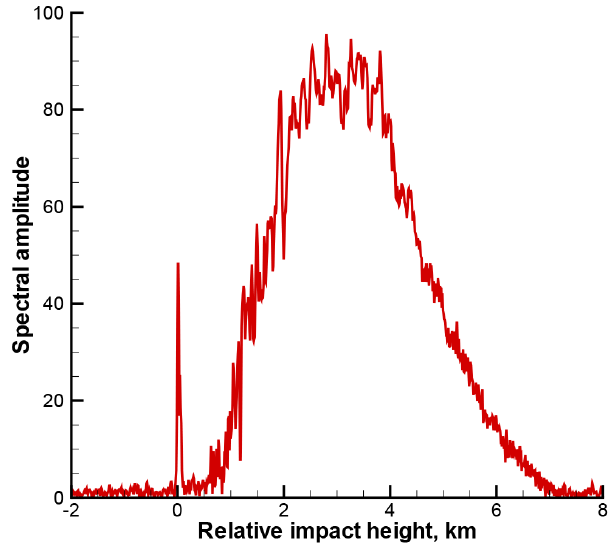
Figure 8. Radio holographic spectrum amplitude | e u R (ω) | for occul- tation event 1 January 2008, 01:02:23UTC, 70.28 ◦ N 121.87 ◦